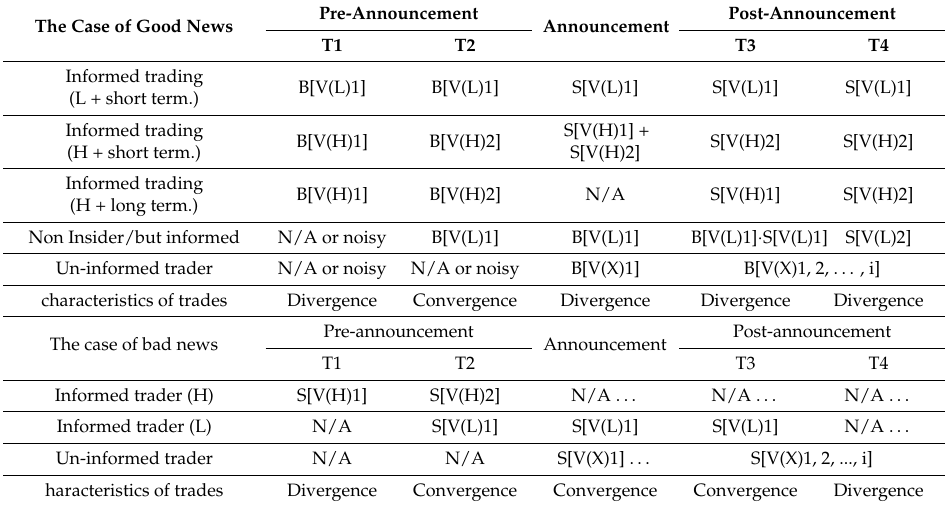
Table 3. Speculation by informed traders around earnings releases (for both good and bad